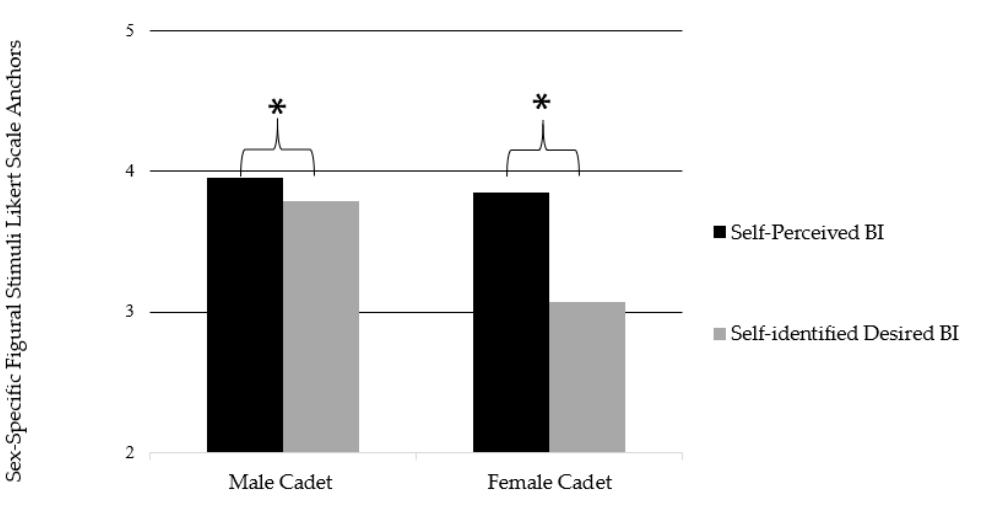
Figure 2. Body Image Scores using Sex-Specific Figural Stimuli Likert Scale Anchors [21]. * Denotes significant differences at the p ≤ 0.01 level.